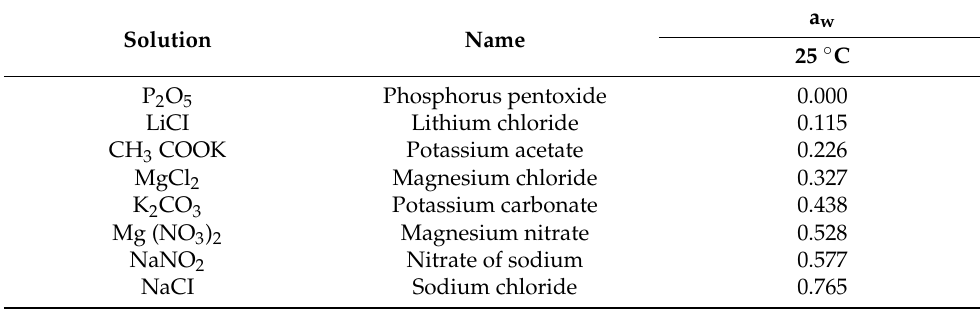
Table 3. Water activities of saturated